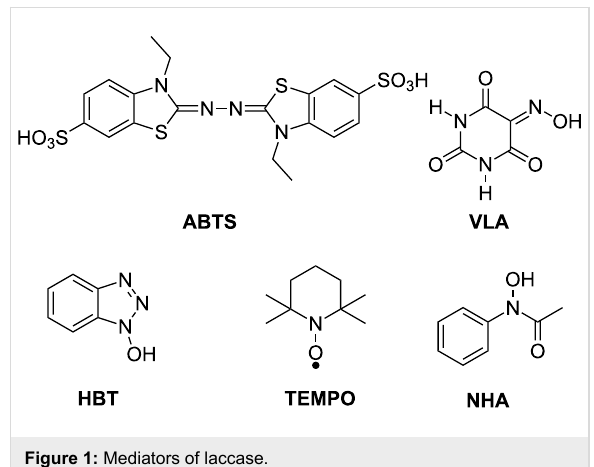
Figure 1: Mediators of